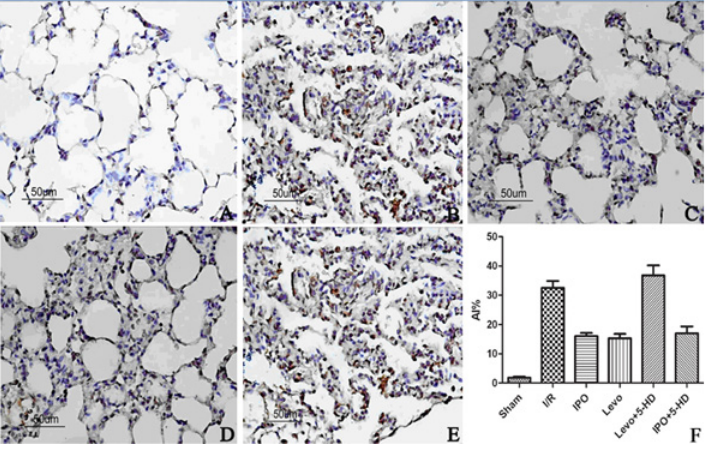
Figure 1. TUNEL staining of apoptotic lung tissue cells in the five groups (×400 magnification). A: Sham group; B: I/R group; C: IPO group; D: Levo group; E: Levo+5-HD group. Apoptotic cells are stained